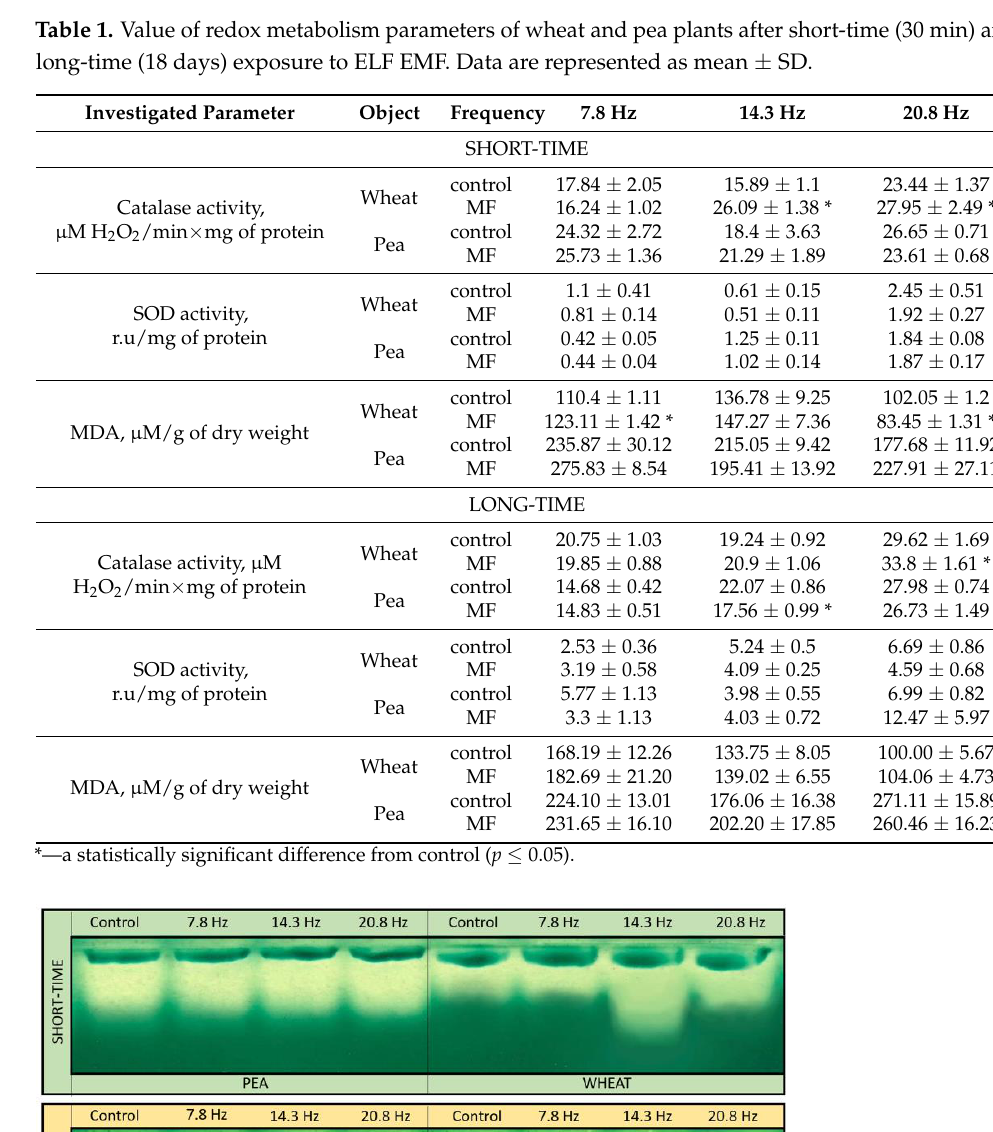
Table 1. Value of redox metabolism parameters of wheat and pea plants after short-time (30 min) and long-time (18 days) exposure to ELF EMF. Data are represented as mean ± SD.